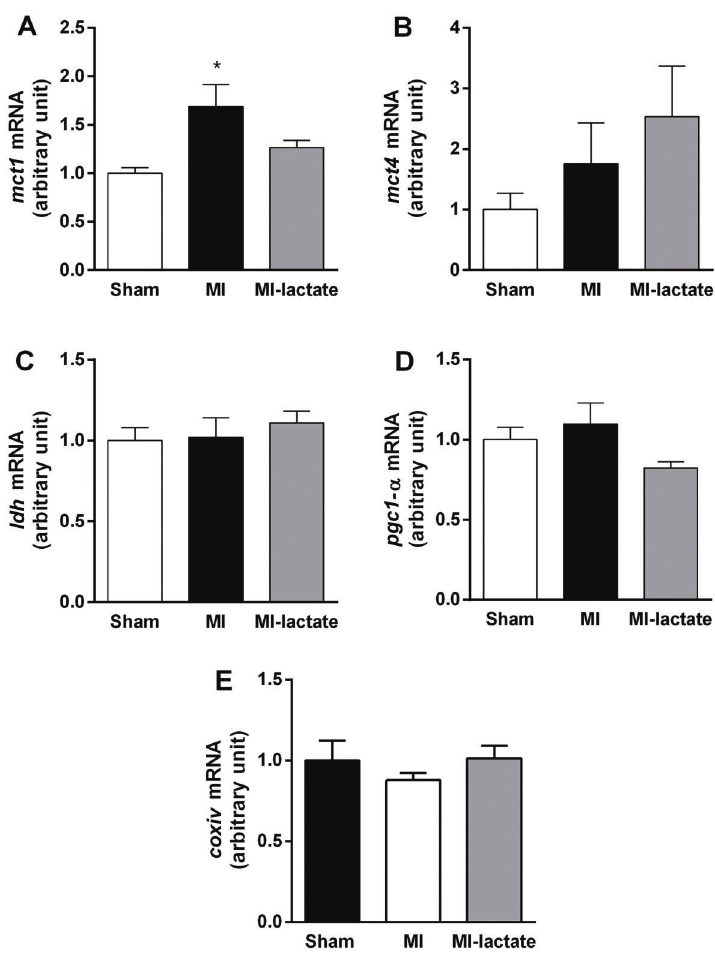
Figure 3. A , Total mRNA levels of monocarbox- ylate transporter ( mct )1, B , mct4 , C , lactate dehydrogenase ( ldh ), and D , proliferator receptor coactivator type 1 alpha ( pgc1- a ) and E , cyto- chrome oxidase IV ( coxiv ) in left ventricle tissue after 60 min of perfusion with Krebs-Henseleit (KH) and KH plus lactate. MI: myocardial infarc- tion. Data are reported as means ± SE of 6 hearts. *P o 0.05 vs Sham group